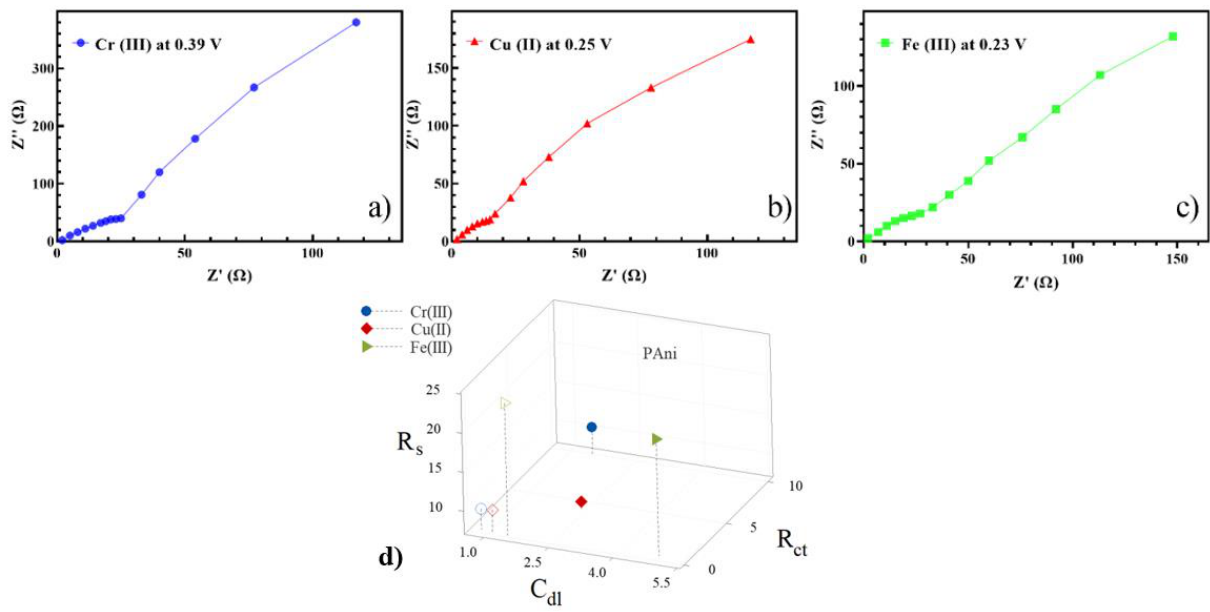
Figure 4. Nyquist spectra of electro-synthesized PAni for the analytes of ( a ) Cr (III), ( b ) Cu (II) and ( c ) Fe (III) at their corresponding reduction potential. ( d ) The values of the elements of the Randles equivalent circuit (filled represents the potential and outline is underpotential).